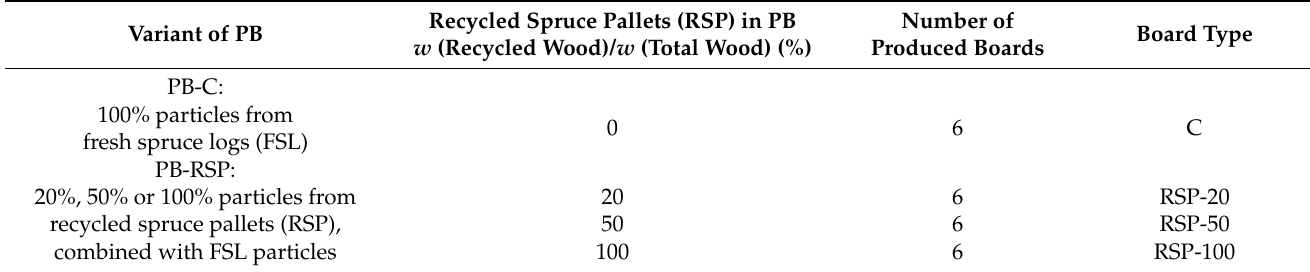
Table 2. Individual types of manufactured particleboards